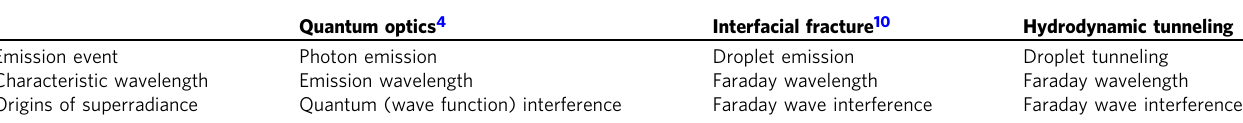
Table 1 Comparison of quantum superradiant photon emission from ion pairs 4 , the hydrodynamic analog of ref. 10 and that developed